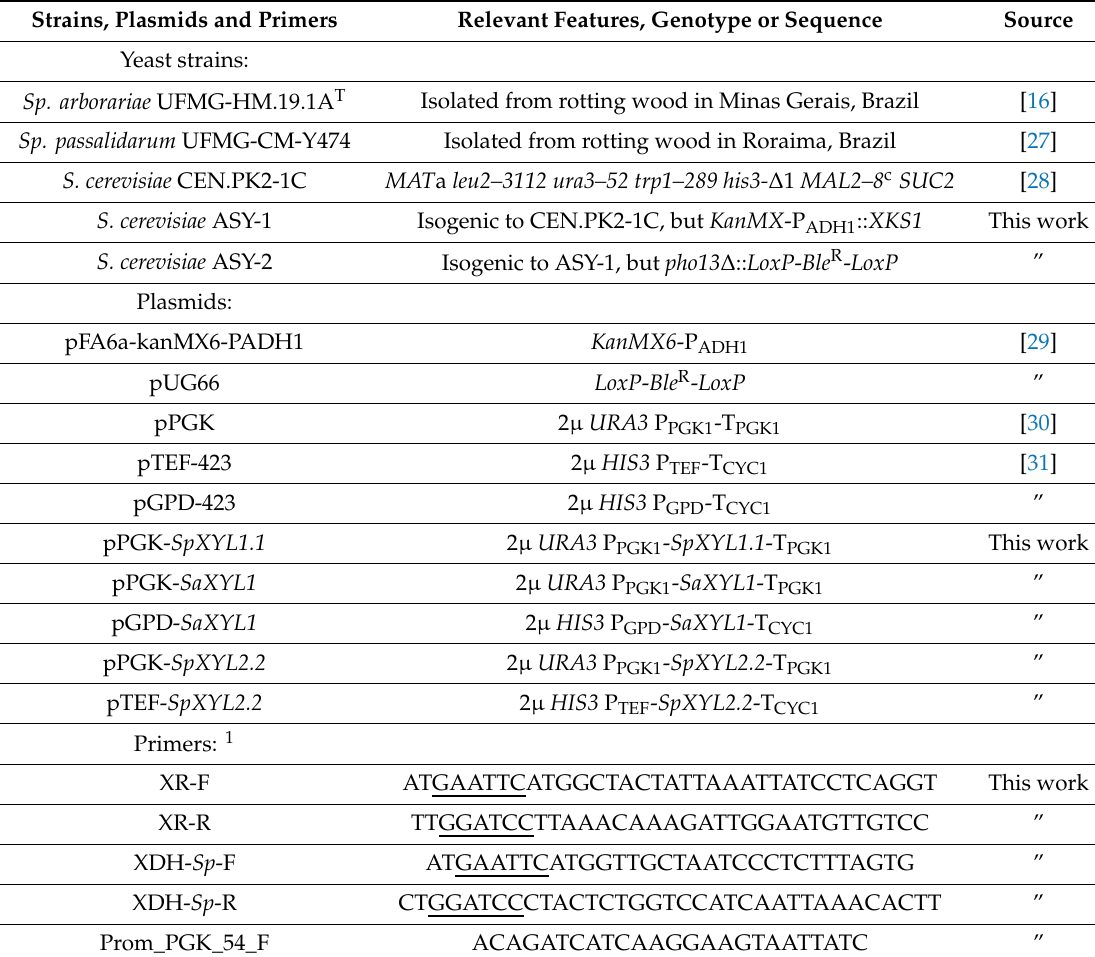
Table 1. Yeast strains, plasmids and primers used in this study. Strains, Plasmids and Primers Relevant Features, Genotype or